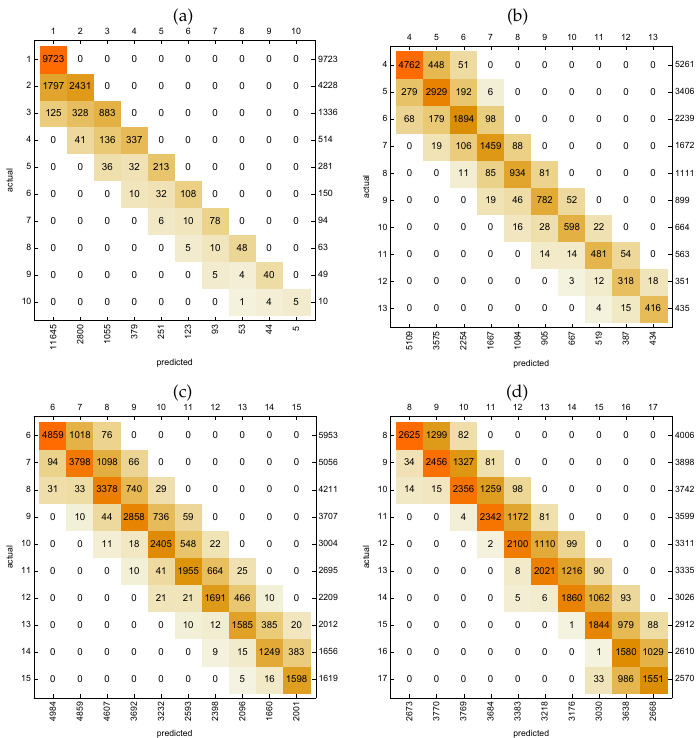
Figure 3. Confusion matrices ( a – d ) for prediction of q 2 , q 3 , q 4 and q 5 using HS.